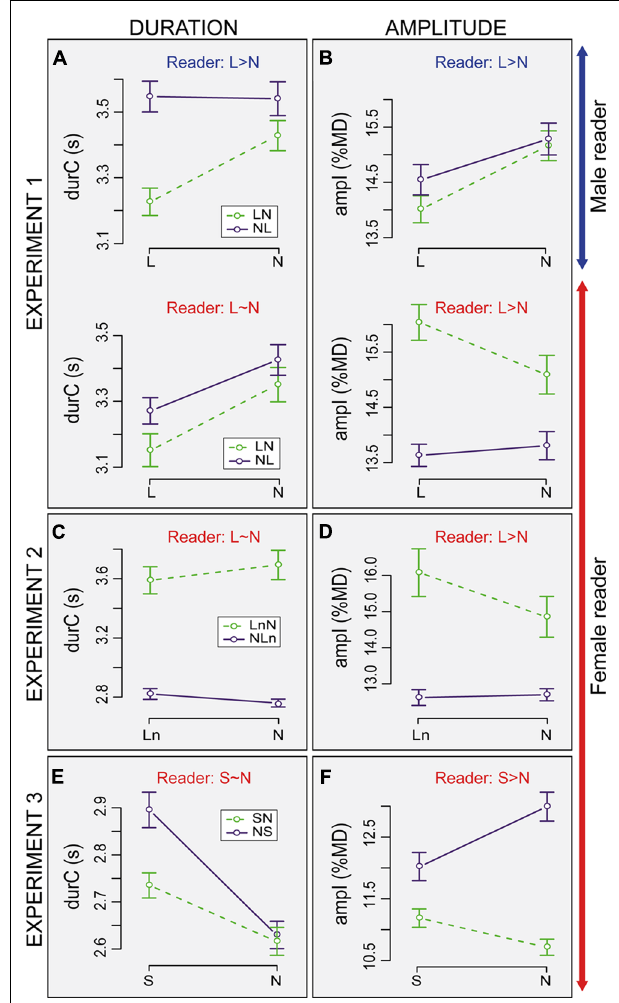
FIGURE 3 |Average duration ( durC ) and amplitude of inhalation ( ampI ) of listener breathing cycles in the three experiments. Data are split according to the speech condition ( N : Normal, L : Loud, Ln Loud played with normal volume, S : Slow) and to the order of presentation ( LN : loud first; NL : normal first, etc.). Bars are ± 1 standard error from the mean.The text labels on the top of each graph are a reference and indicate the direction of the effect for the readers for each parameter. Results for duration (A,C,E) , amplitude (B,D,F) , Experiment 1 (A,B) , Experiment 2 (C,D) , Experiment 3 (E,F)